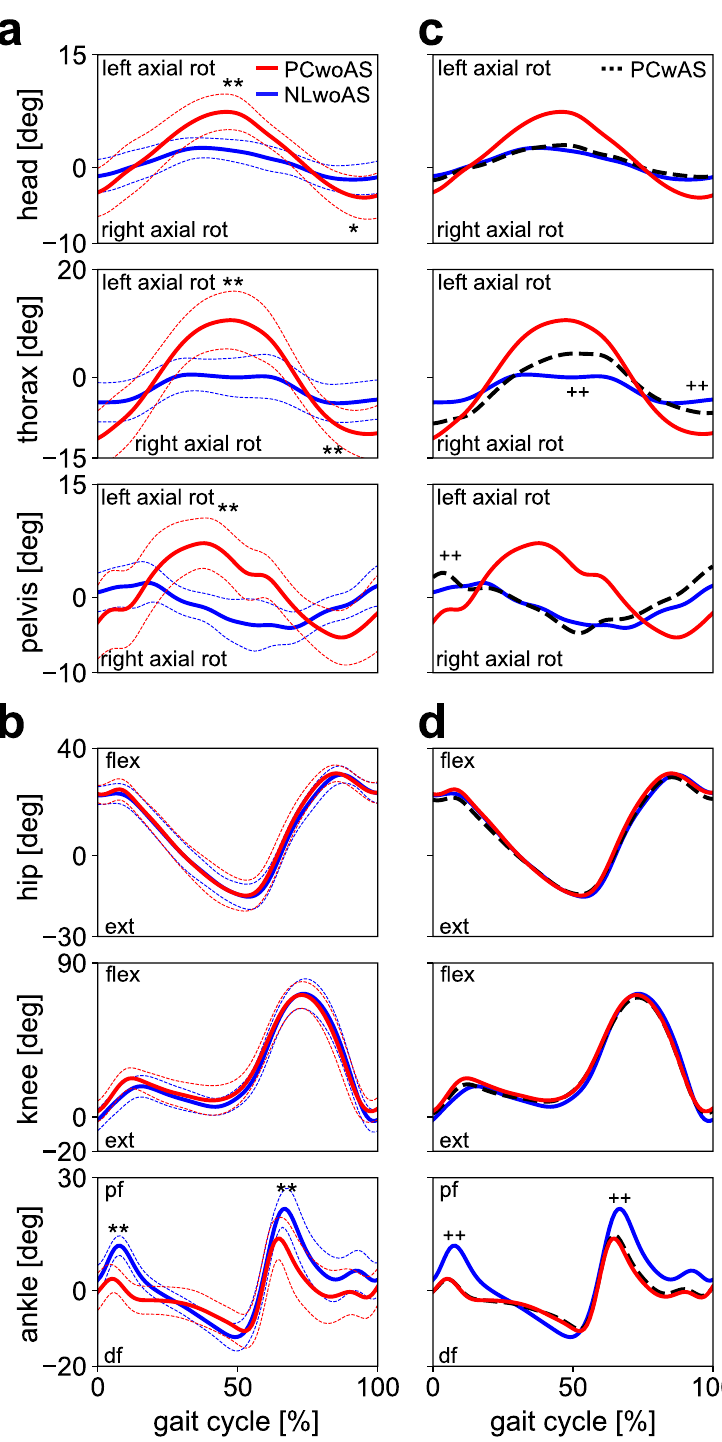
Figure 3. Mean trunk segment ( a ) and joint angle ( b ) profiles during walking with NL and PC shoes when the arm swing was restrained (NLwoAS and PCwoAS, respectively). Mean segment and joint angle profiles were also compared with those with PC shoes when the arm swing was not restrained (PCwAS) ( c , d ). Blue solid line = NLwoAS, Red solid line = PCwoAS. Corresponding dashed lines represent standard deviations. Black dashed line = PCwAS. Asterisks indicate statistical differences of the maximum or minimum values between NLwoAS and PCwoAS (*: p < 0.05. **: p < 0.01). Pluses indicate statistical differences between NLwoAS and PCwAS (+: p < 0.05. ++: p <